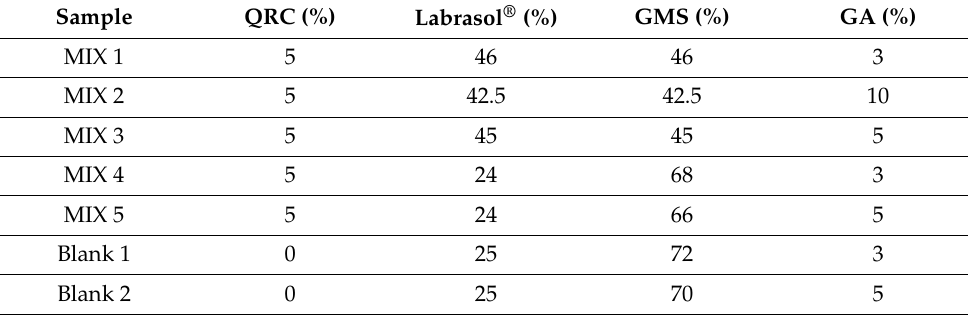
Table 1. Percentage composition (w/w) of the lipid